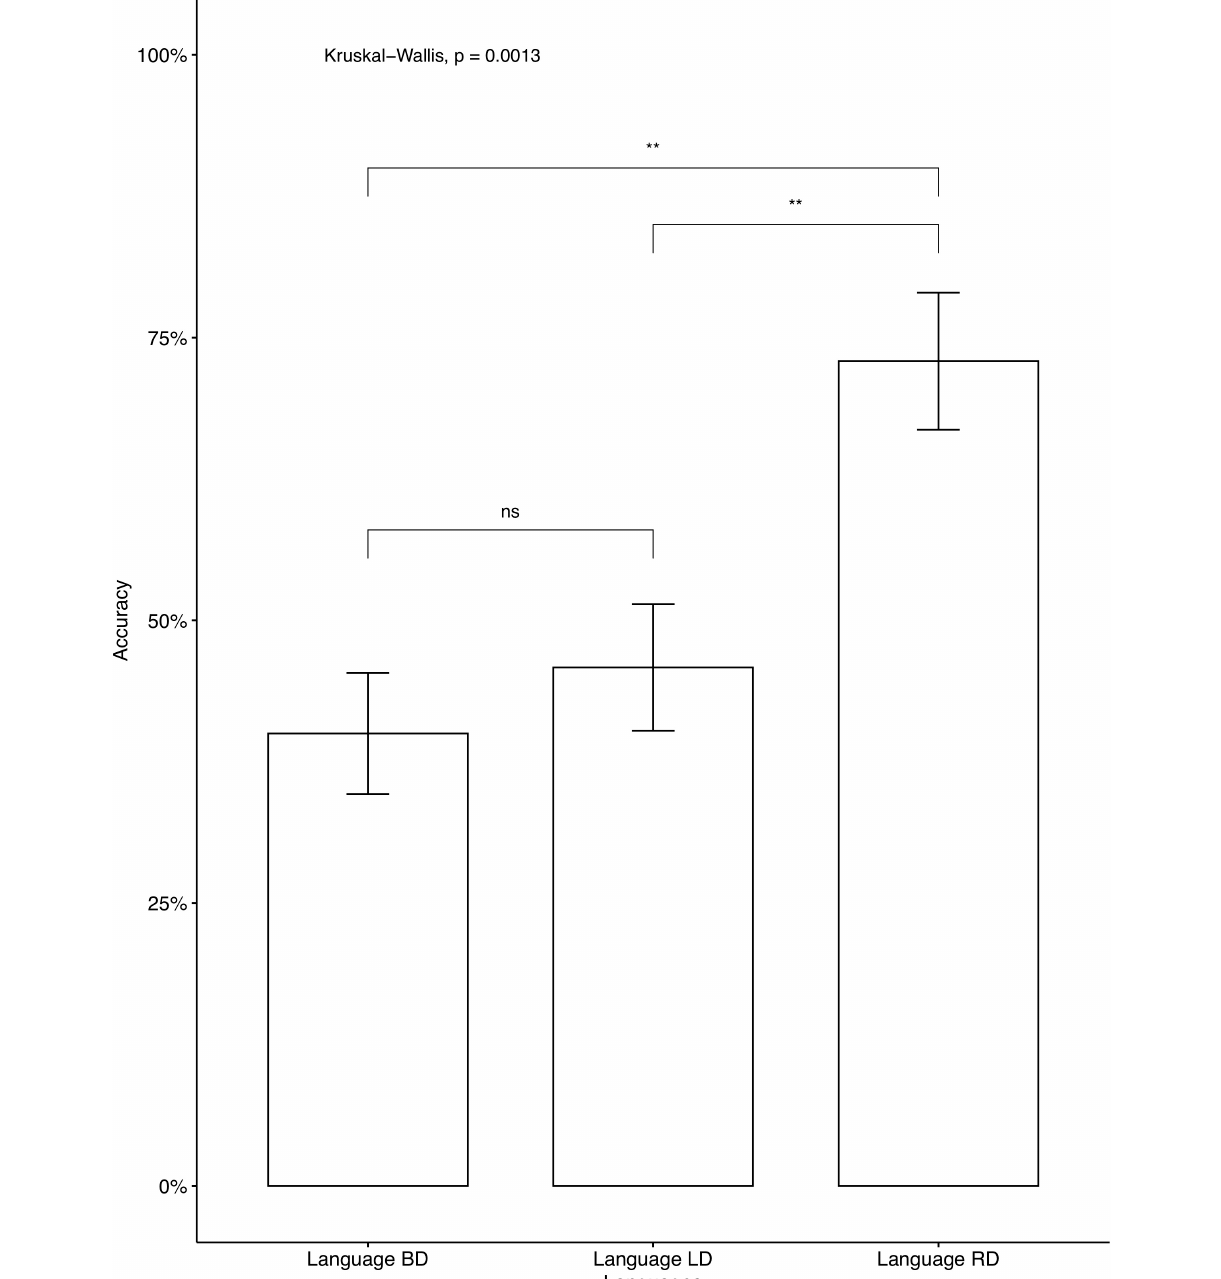
significant difference was found between Language LD and RD on fillers [ t (443.84) = –0.87, p = 0.387]. These results indicate that participants who learned the two uni-directional languages (Language LD and Language RD) performed better on fillers than those who learned the bi-directional language (Language